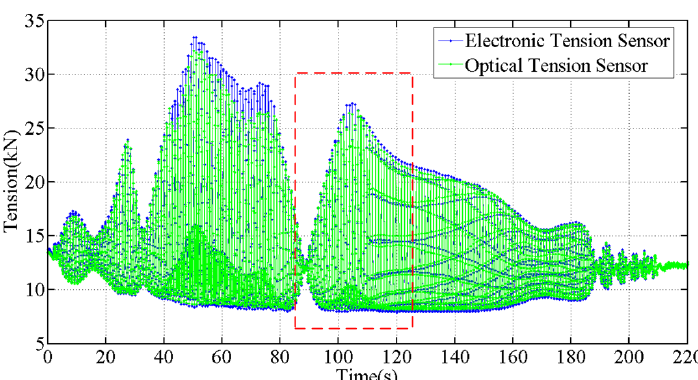
Figure 11. The tension measured during the galloping (frequency is 1.02 Hz), the curve in the red dashed box is shown in Figure 12.